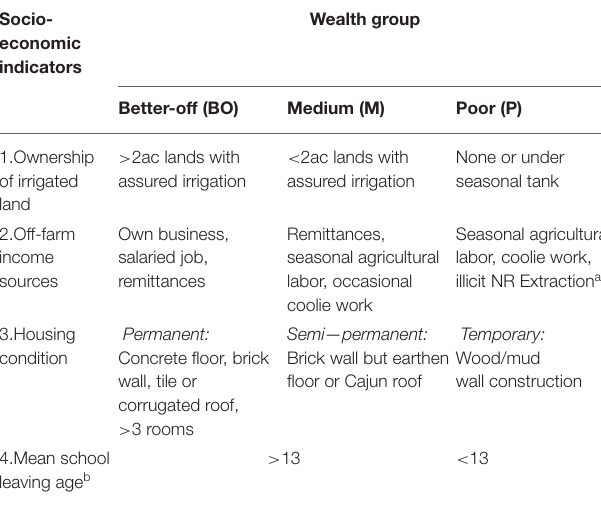
TABLE 3 | Key informant wealth ranking indicators and